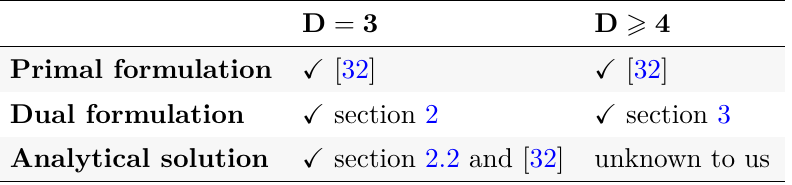
Table 1 . Optimization of low energy constants (LECs) of the flux tube